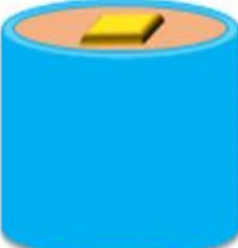
Figure 1. Illustration of specimen embedded in the poly(vinylchloride) tube.